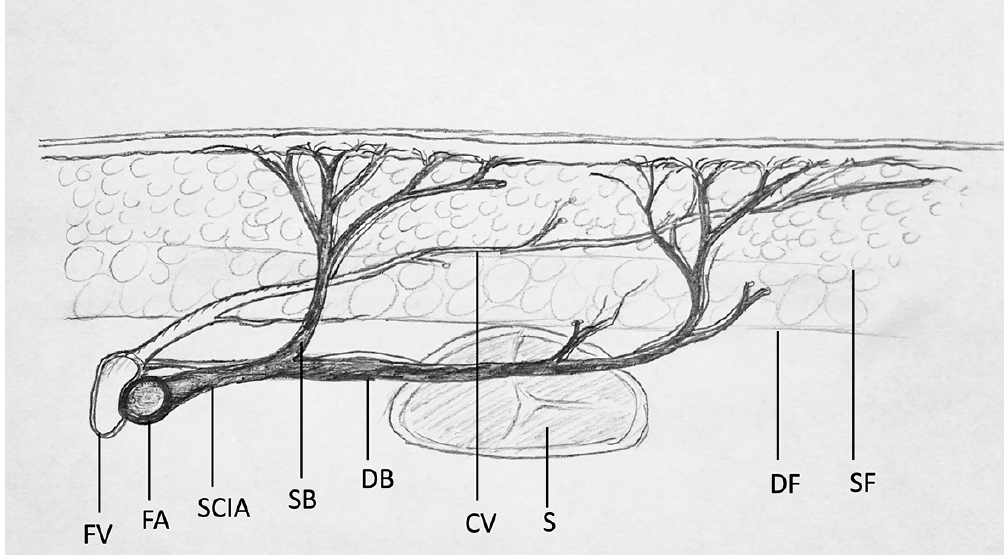
Figure 2. Simplified overview of the anatomy of the SCIA. FV = femoral vein; FA = femoral artery; CV = cutaneous vein; SB = superficial medial branch of SCIA; DB = deep lateral branch of SCIA; SCIA = superficial circumflex iliac artery; S = sartorius; DF = deep fascia; SF = superficial fascia. Quantitative parameters such as vascular diameter and blood flow properties such as pulse systolic velocity (PS), end diastolic velocity (ED), as well as the resistance index (RI) were measured at the emergence point of vessels at the level of penetration of the deep fascia.